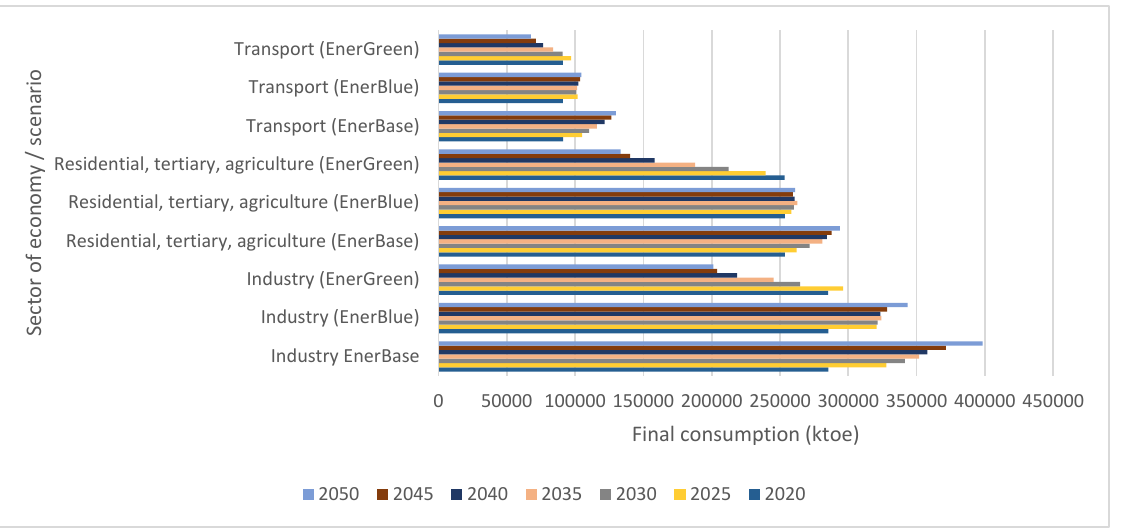
Figure 2. Total final energy consumption in the CIS countries by sector, ktoe. Notes: Other sectors’ final consumption is insignificant and constitutes 0.00–0.02 in 2030–2050 in all scenarios. Source: based on data from [30].